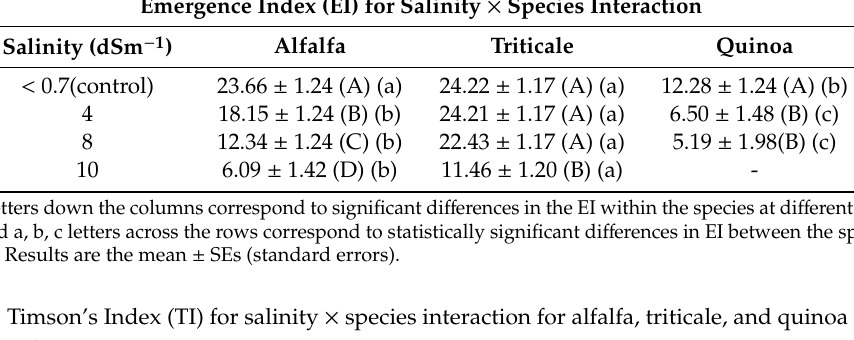
Table 7. Emergence index (EI) for salinity × species interaction for alfalfa, triticale, and quinoa at four di ff erent salinities.